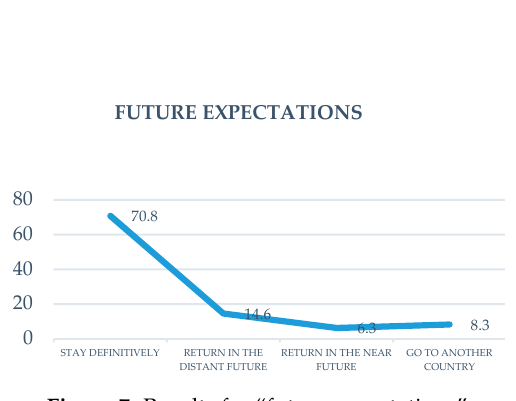
Figure 7. Results for “future expectations”.